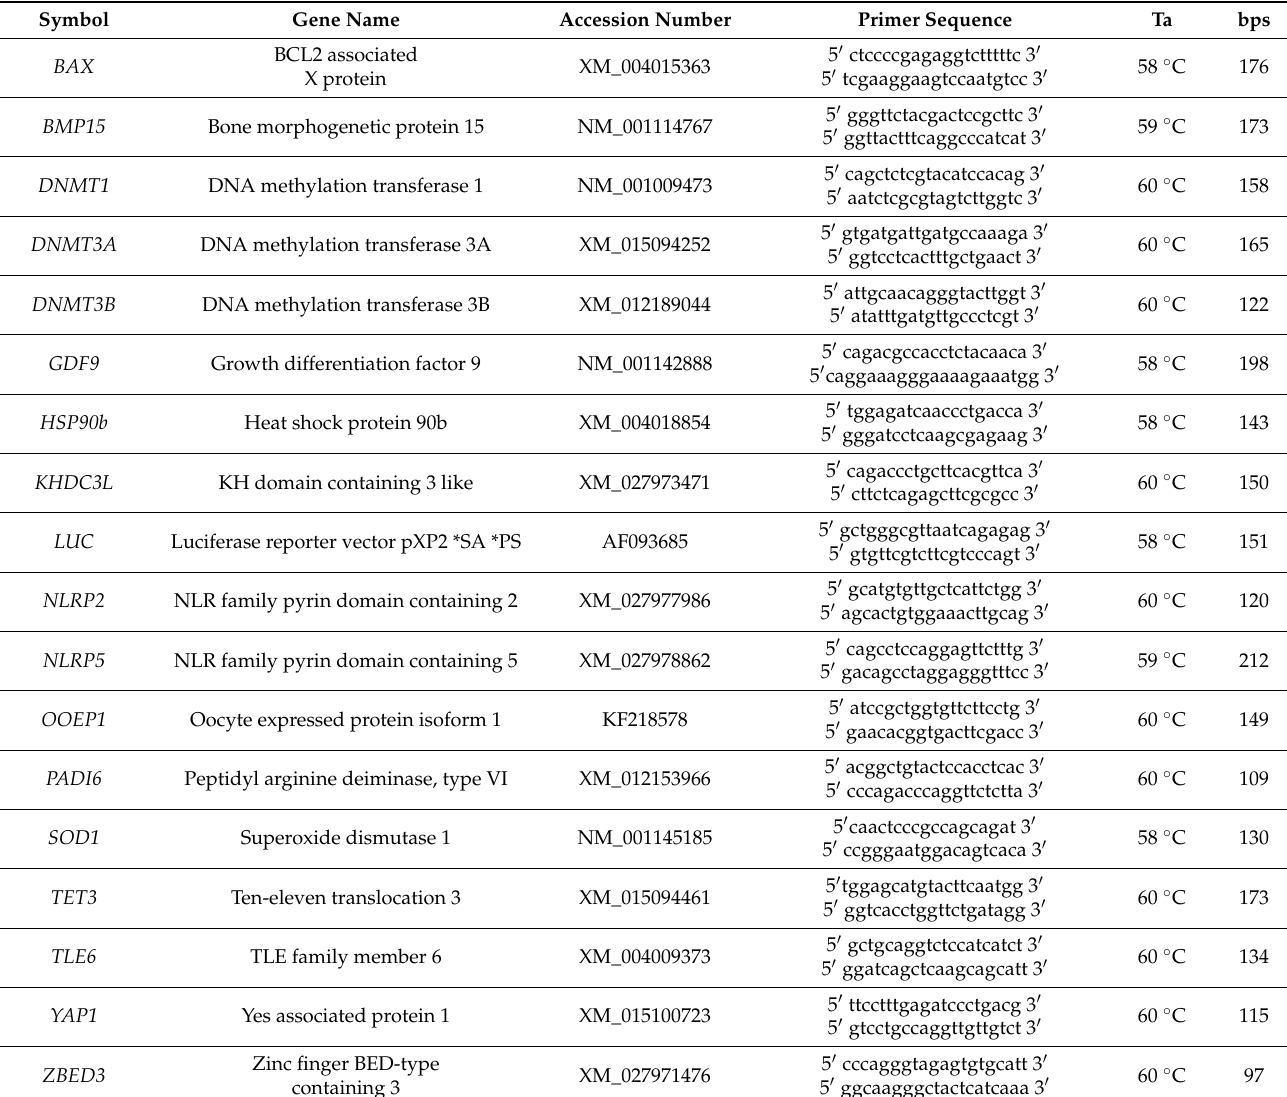
Table 2. Primers used for real-time PCR experiments. Ta: annealing temperature. Bps: base